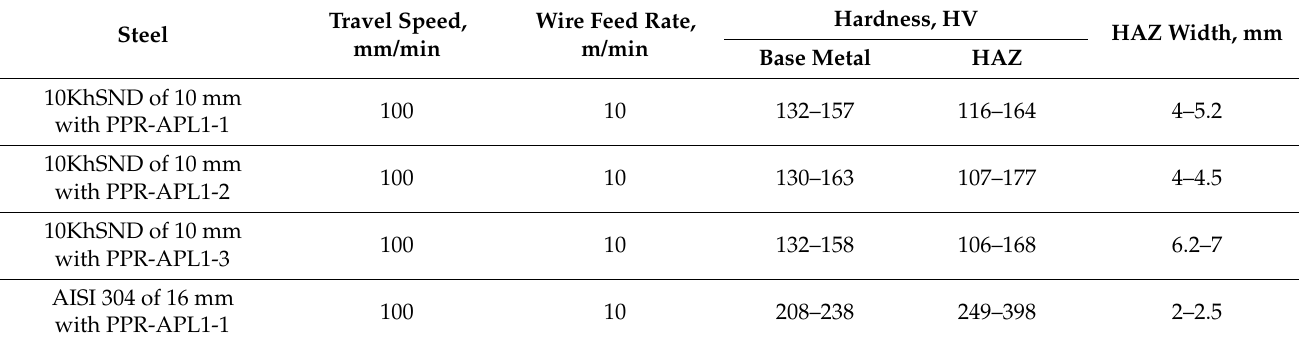
Table 7. Hardness and HAZ width in underwater wet cutting of steels.